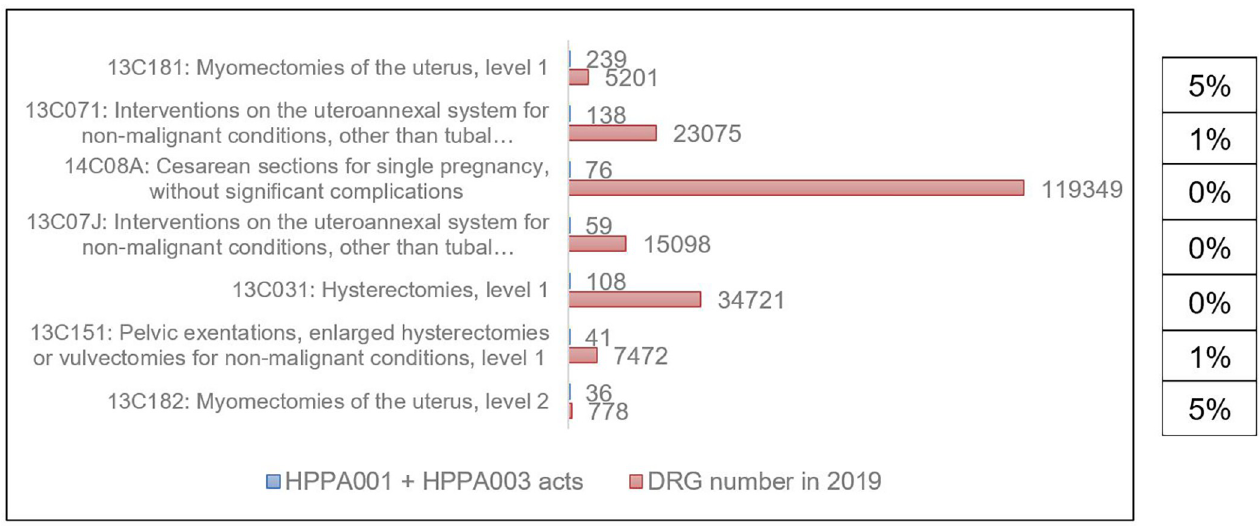
Fig 2. Main DRG according to HPPA001 and HPPA003 medical acts and percentage of both acts in the general DRG.